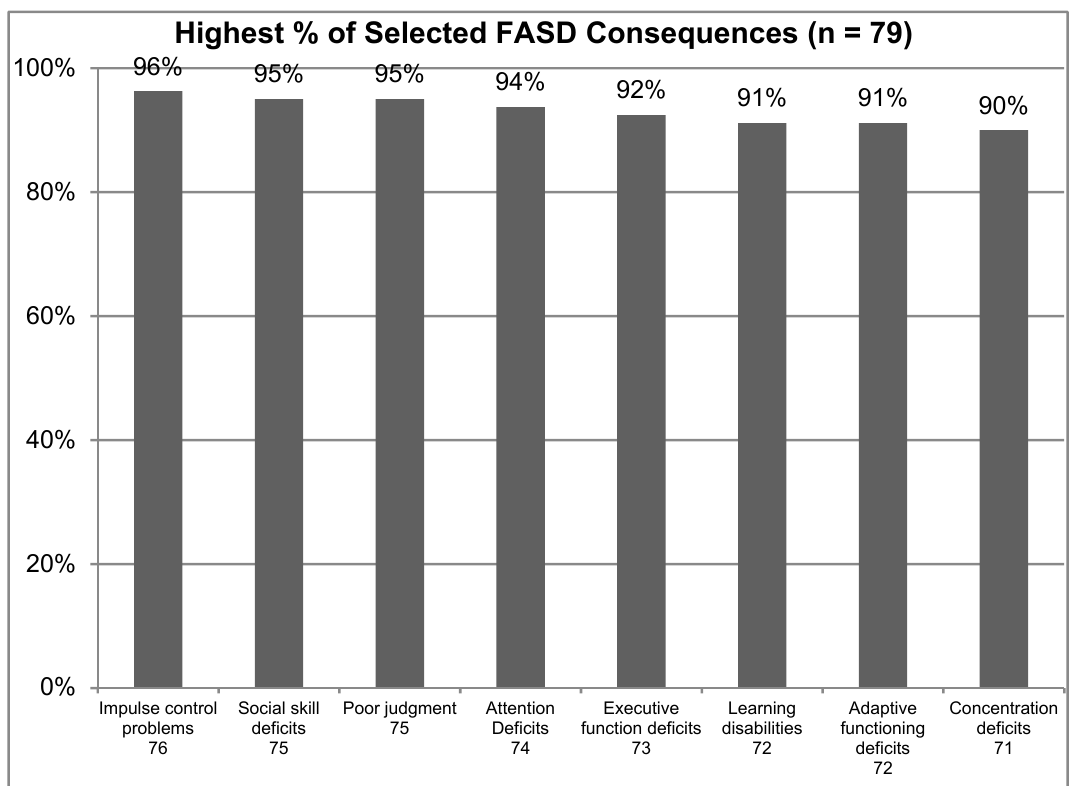
Figure 1. Highest % of selected Fetal Alcohol Spectrum Disorder (FASD) consequences.